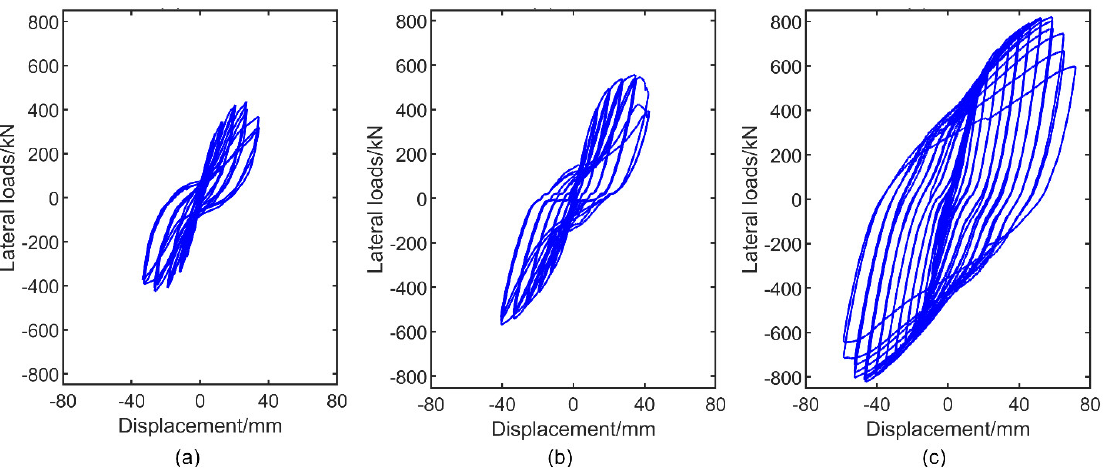
Figure 11. Hysteretic curves of specimens under displacement control loading: ( a ) SPSW; ( b ) SCSW; ( c ) DCSW.